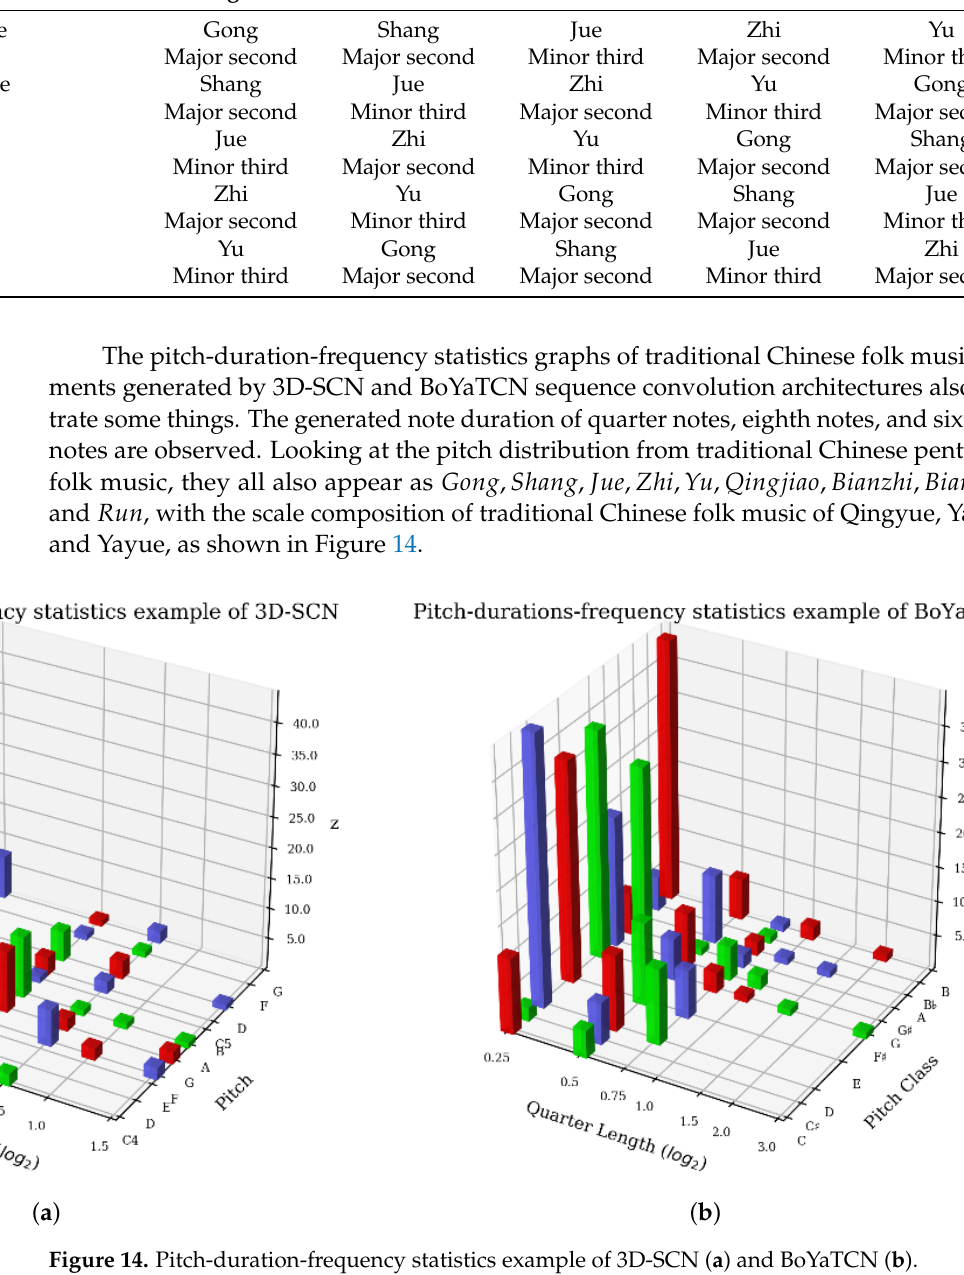
Figure 14. Pitch-duration-frequency statistics example of 3D-SCN ( a ) and BoYaTCN ( b